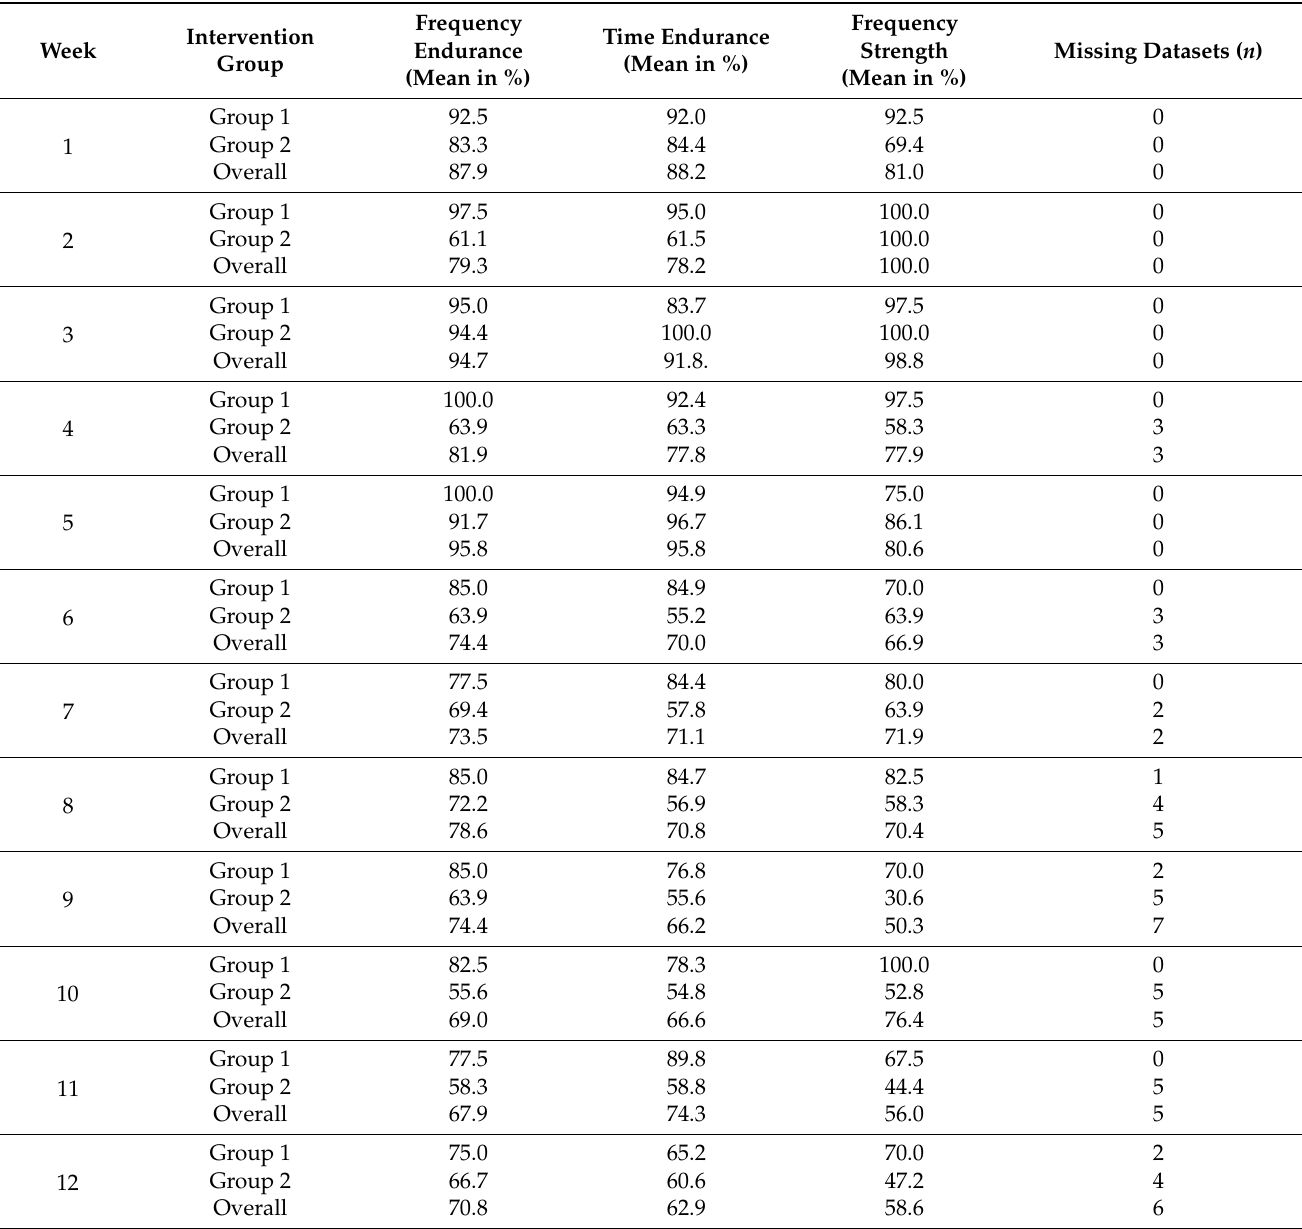
Table A2. Adherence to prescribed exercise according to the training logs (phase 1) for the complete cases ( n = 38), displaying overall adherence to frequency and time of endurance and strenght training and adherence seperated by the two recruitment